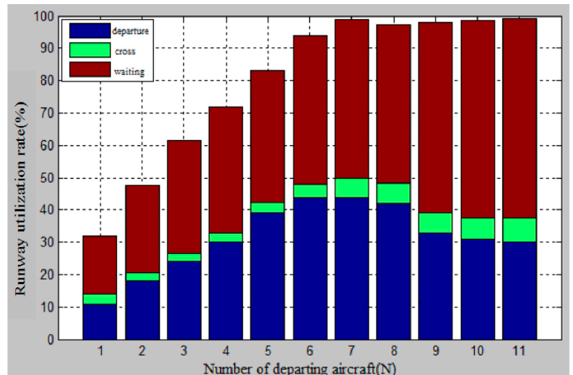
Figure 2. The relationship between runway utilization and the number of departing aircraft.